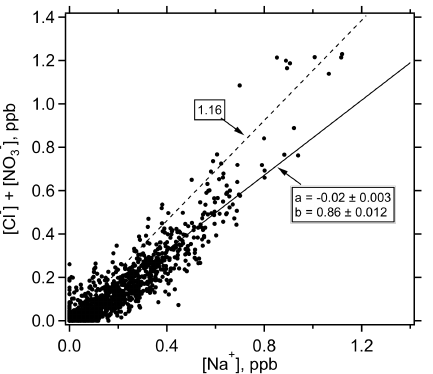
Figure 11. Relationship between concentrations of aerosol Cl − and Na + with NO − included to account for the displaced Cl − due to 3 SSA acidification by H 2 SO 4 . The dash line represents the sea-water Cl − to Na + ratio of 1.16, and the solid line a least square fit of the data whose intercept and slope are indicated.